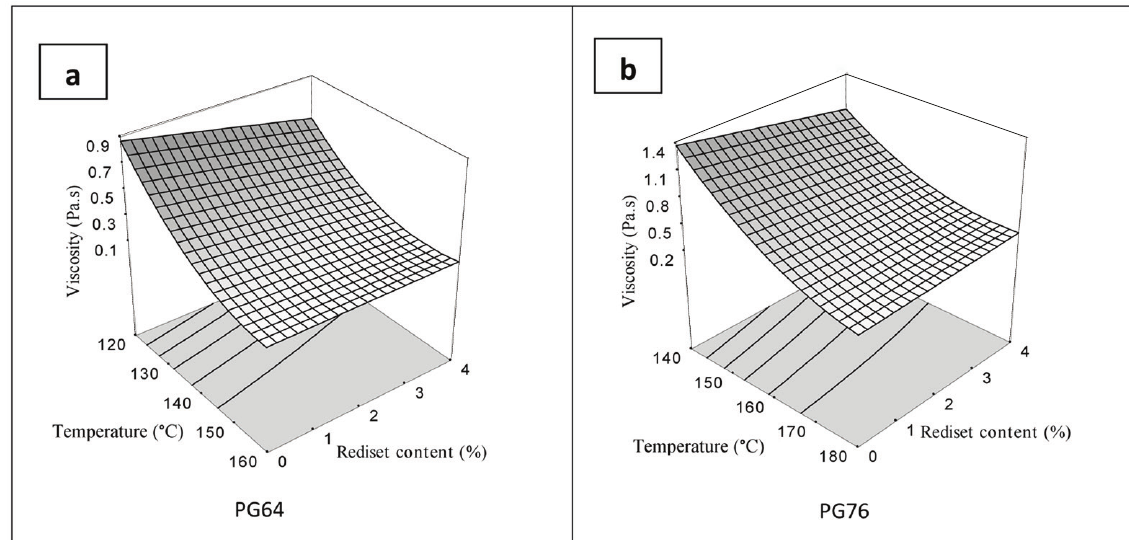
Fig. 3. Plot of response surface for the viscosity value for unaged